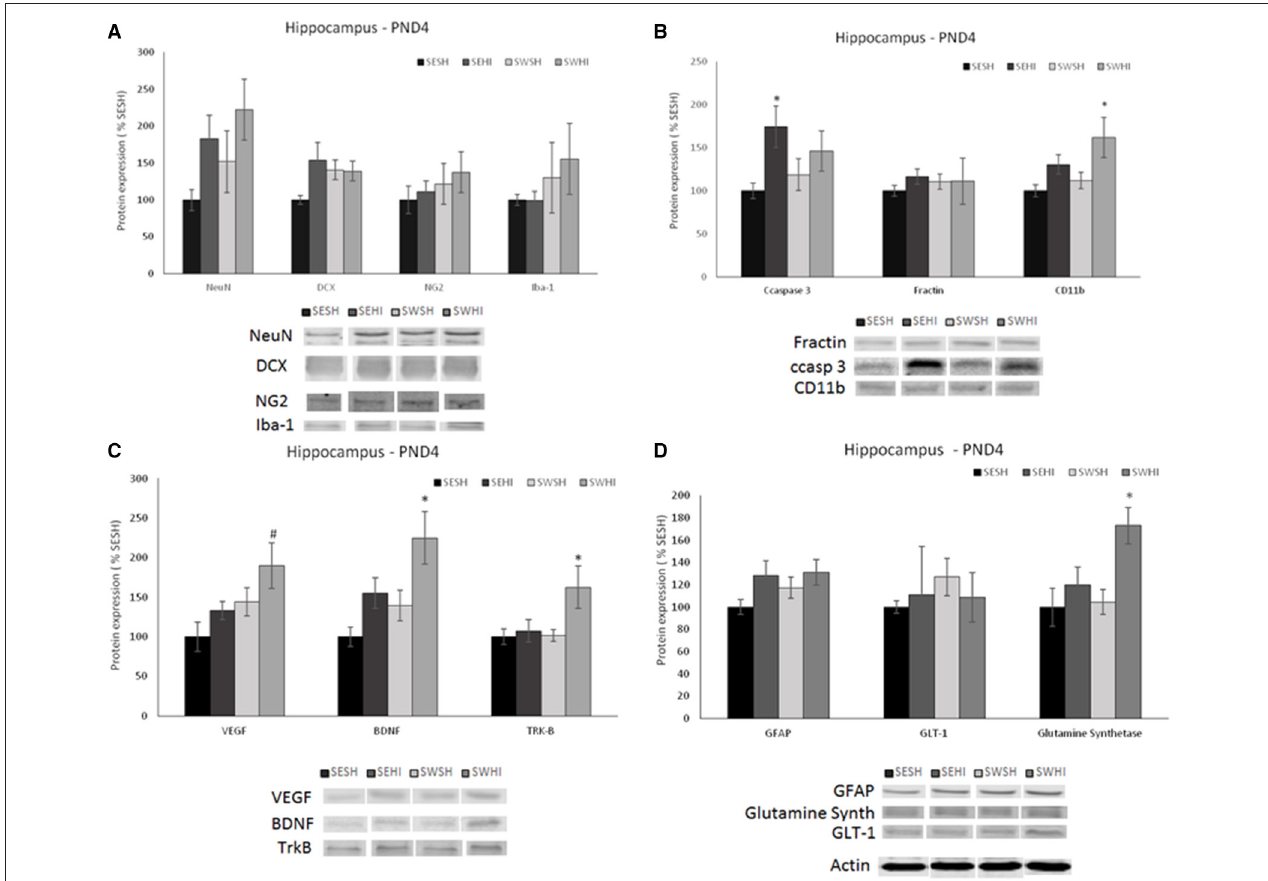
FIGURE 3 | Effect of pregnancy swimming on the pup’s protein levels on the right hippocampus extracts 24h following HI (PND4). Bars graph represent immunoblots of (A) neurons (NeuN) and migrating neurons Doublecortin (DCX), oligodendrocytes progenitors (NG2) and microglia (Iba-1); (B) cell death (ccaspase 3 and fractin) and inflammation (CD11b), (C) neurotrophins VEGF and BDNF and the TRK-B receptor and (D) astrogliosis (GFAP), glutamate receptor GLT-1 and glutamine synthetase enzyme in the four experimental groups: sedentary sham (SESH), sedentary hypoxic-ischemic (SEHI), swimming sham (SWSH) and swimming hypoxic-ischemic (SWHI). WB results are plotted normalized to SESH level expression (100%) (mean ± SEM). Significance testing was determined using one-way ANOVA followed by Duncan’s post-hoc and was performed on Actin or β III-tubulin normalized data. *HI vs. its respective SH group. # SWHI vs. SESH and SEHI. Significance accepted when p <